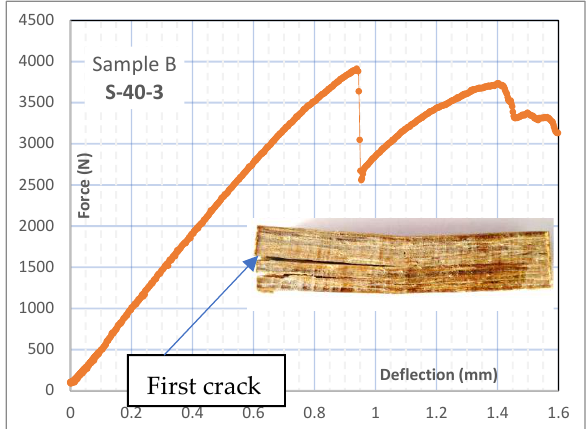
Figure 11. Force – deflection (3-point test); local failure does not happen in a few S-40-3 samples. Samples were exposed to T = 20 °C for three and seven days. Original conditions: T = 20 °C and H = 60%. Only in a few samples did cracks occur in the middle.